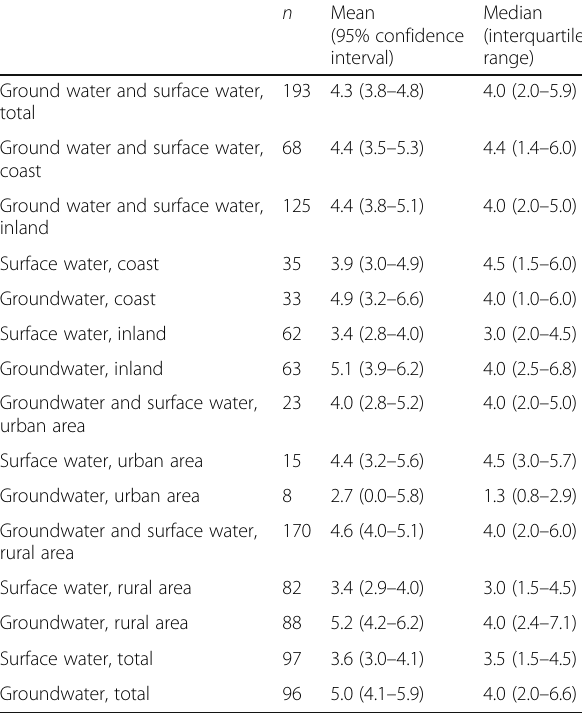
Table 2 Mean (95% confidence interval) and median (interquartile range) water iodine concentration, WIC ( μ g/L),